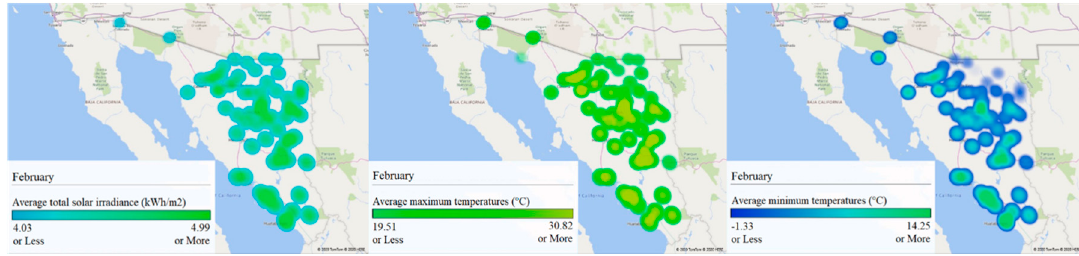
Figure 8. GIS analysis of Sonora for February: ( left ) average solar total radiation (kWh/m 2 ), ( center ) maximum average temperatures (°C), and ( right ) minimum average temperatures (°C).